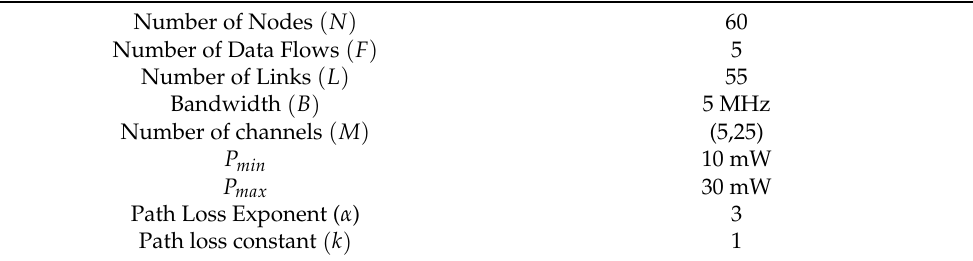
Table 2. System parameter